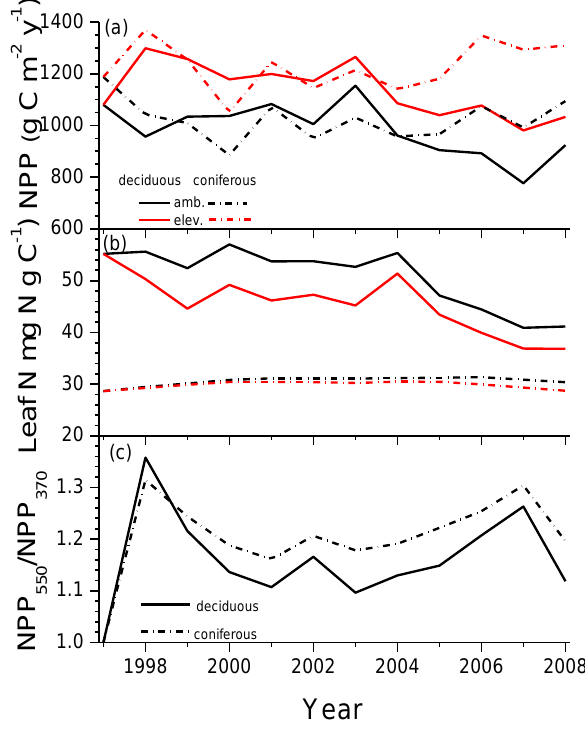
Fig. 9. (a) Annual net primary productivity (NPP), (b) leaf N con- centrations and (c) ratios of NPP modelled from 1998 to 2008 under ambient ( ∼ 370µmolmol − 1 ) vs. elevated ( ∼ 550µmolmol − 1 ) C a with deciduous vs. coniferous plant functional types at the ORNL FACE experiment. Values of NPP and leaf N concentrations mod- elled with the deciduous plant functional type are the same as those in Fig. 5a and Fig.